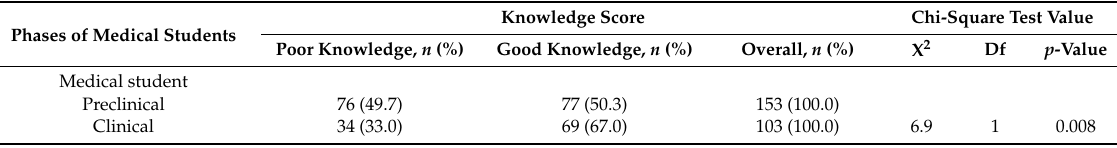
Table 6. Association of knowledge score on hand hygiene practices and preclinical vs. clinical medical students. Phases of Medical